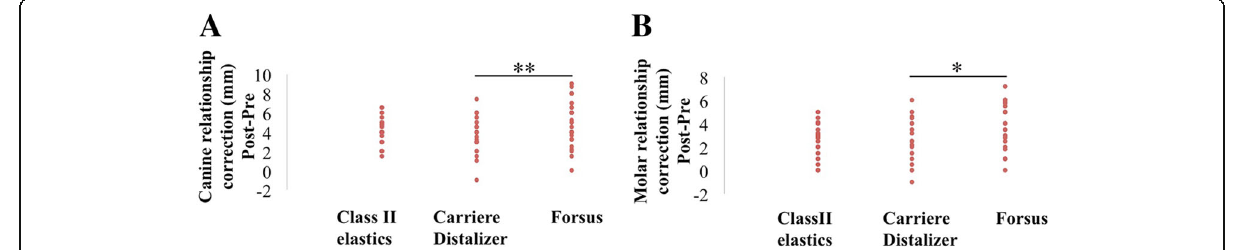
Fig. 4 a , b Quantification of Class II correction based on measurements from pre- and post-treatment study models. * P < 0.05, ** P < 0.01, *** P < 0.001